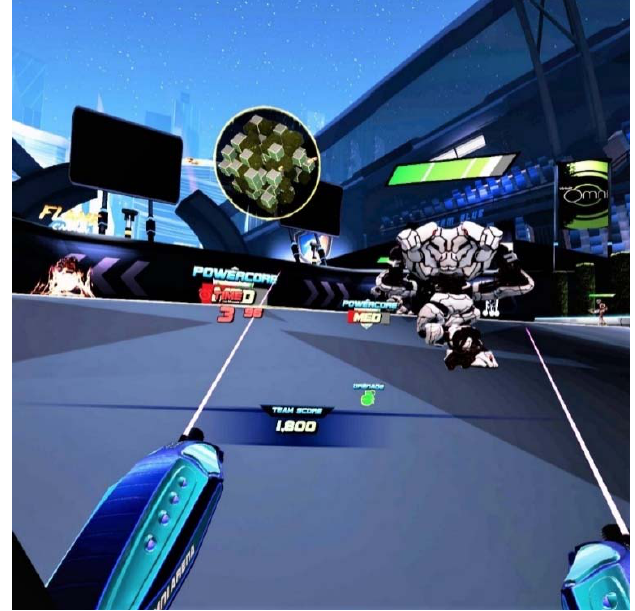
Figure 2. Gameplay of Core Defense game: print screen.